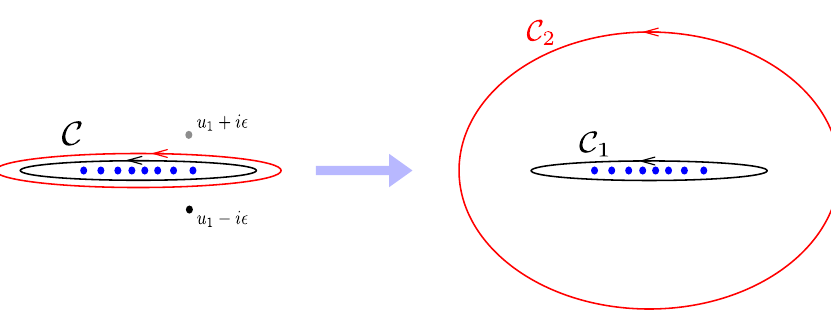
Figure 4 . Deformation of the integration contours. Left: the integration contours for u 1 (black) and u 2 (red) in (2.42). The two contours are on top of each other and encircle the eigenvalues of M (the blue dots in the (cid:12)gure). Right: the integration contours in (2.46). When we deform the contour of u 2 , the integral picks up a contribution from poles at u 2 = u 1 (cid:6) i(cid:15) (the gray and black dots). The residue at u 1 + i(cid:15) turns out to vanish while the residue at u 1 (cid:0) i(cid:15) cancels the second term in